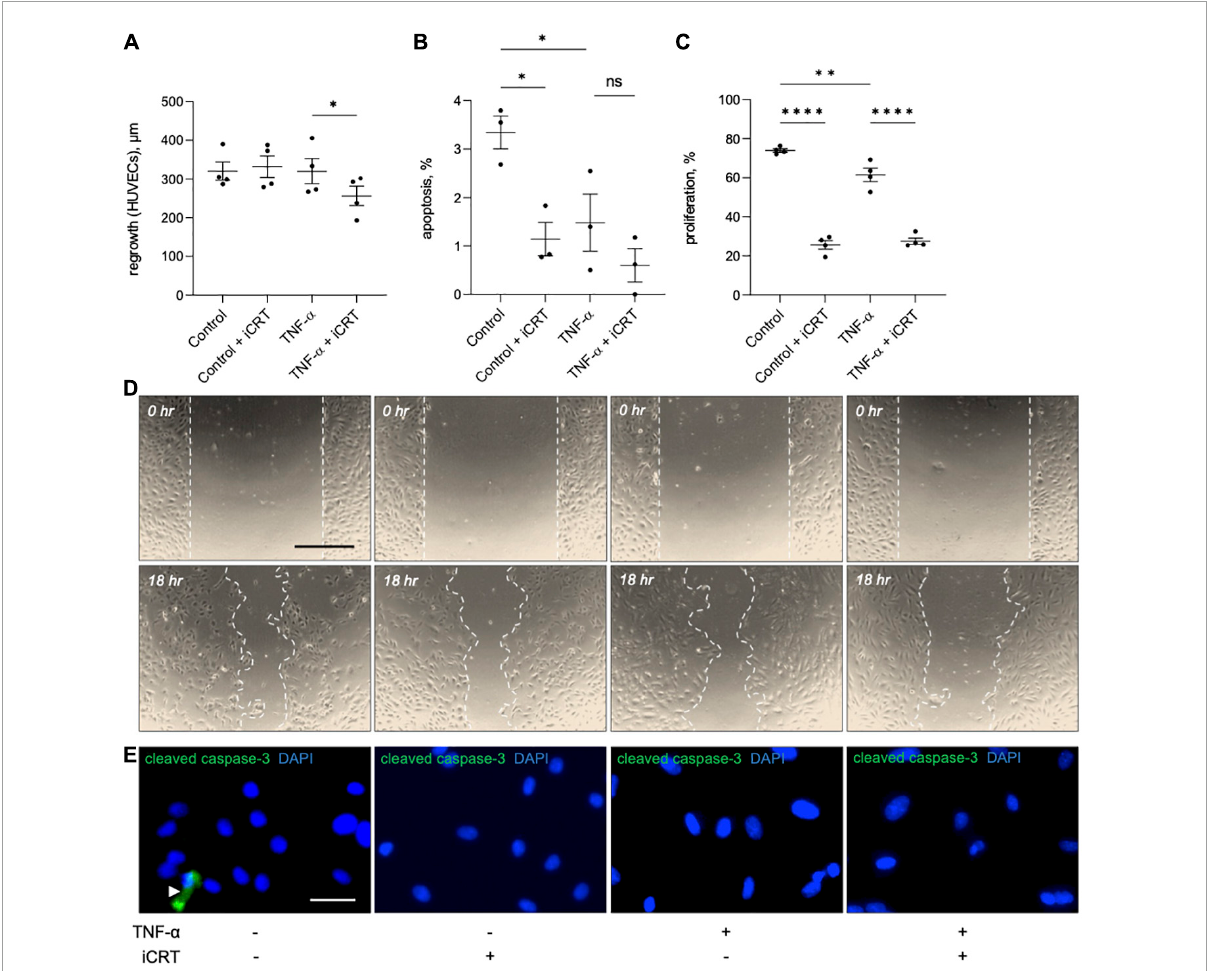
FIGURE6 Effects of inhibition of Wnt/ β -catenin signaling on wound healing, apoptosis and proliferation in cultured endothelial cells. Human umbilical vein endothelial cells (HUVECs) were treated with either 0.05% DMSO vehicle control or 25 µ M inhibitor of β -catenin-responsive transcription (iCRT) in the presence or absence of 10 ng/mL recombinant human tumor necrosis factor- α (TNF- α ) stimulus for 18 h. (A) HUVECs were subjected to scratch wounding and regrowth was quantified; data is expressed in µ m ( n = 4 each). (B) HUVECs were subjected to immunofluorescence for cleaved caspase-3, and apoptosis quantified and expressed as the percentage of cleaved caspase-3-positive cells ( n = 3). (C) HUVECs were subjected to fluorescent labeling of incorporated EdU, and proliferation quantified and expressed as the percentage of EdU-positive cells ( n = 4). (D) Representative images of scratch wound assay performed on HUVECs. Dashed line indicates wound edge. Scale bar represents 500 µ m. (E) Representative images of HUVECs immunostained (green) for cleaved caspase-3. White arrowhead indicates cleaved caspase-3-positive cell. Nuclei were stained with DAPI (blue). Scale bar represents 10 µ m and applies to all panels. ∗ Indicates p < 0.05, ∗∗ p < 0.01, ∗∗∗ p < 0.001, and ∗∗∗∗ p < 0.0001. NS denotes not